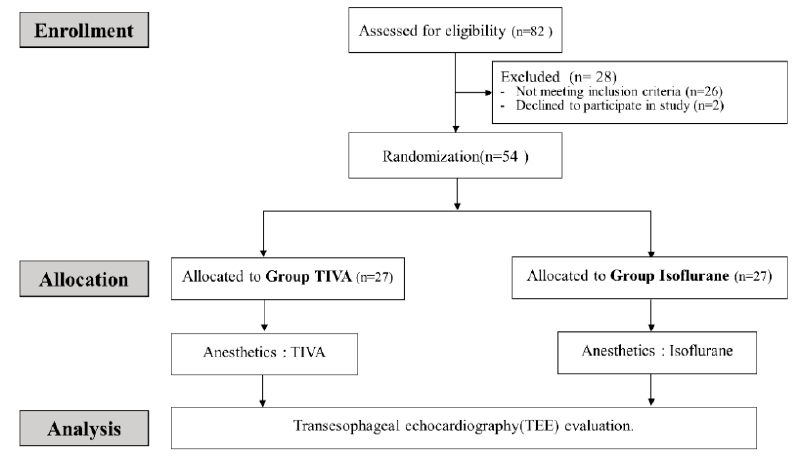
Figure 1. CONSORT flow diagram.